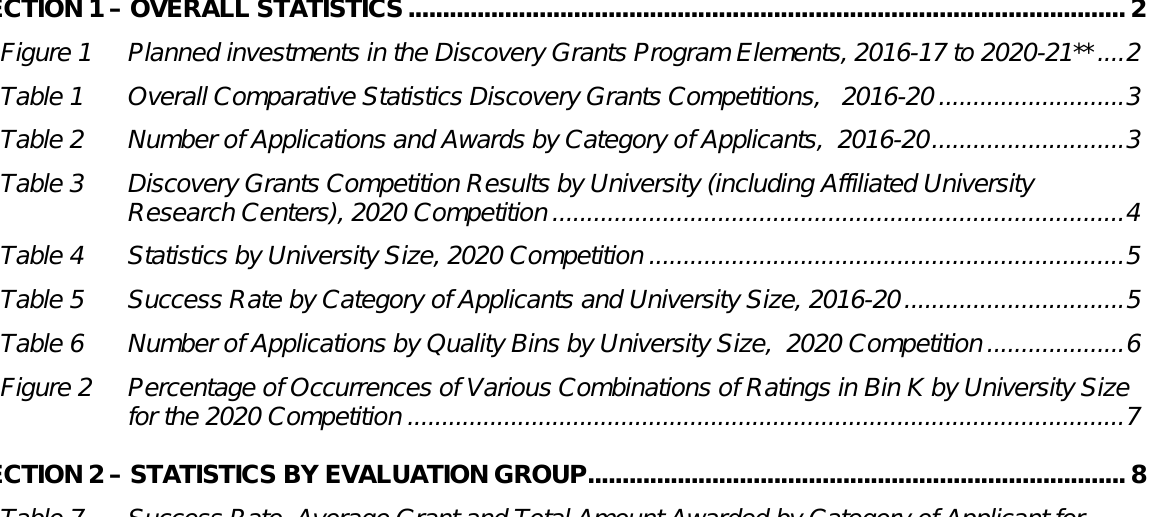
Success Rate, Average Grant and Total Amount Awarded by Category of Applicant for Distribution of the Percentage of Applications by Quality Bin for Each Evaluation Group,